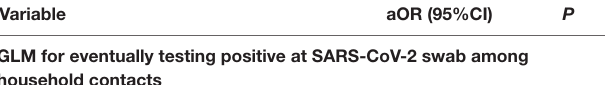
TABLE 2 | Multivariate models for factors associated with differential risk of secondary SARS-CoV-2 cases among household contacts.